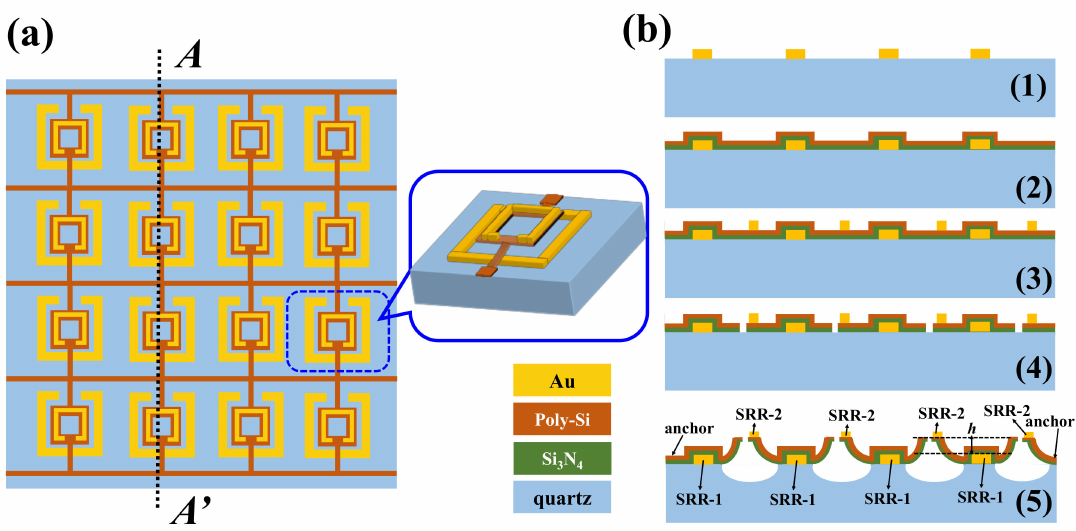
Figure 10. Schematic drawing of ( a ) proposed MEMS-based TTM-1 array; ( b ) Fabrication process of proposed TTM-1 using MEMS technique along AA’ line in ( a ); ( b1 ) The SRR-1 structures are deposited and patterned by using lift-off and sputtering processes sequentially; ( b2 ) The poly-Si and Si 3 N 4 thin-films are deposited on sample surface using PECVD process sequentially. ( b3 ) The SRR-2 structures are deposited and patterned by using lift-off and sputtering processes sequentially. ( b4 ) Sample is patterned by using photolithography and RIE processes to define the ETAs structures. ( b5 ) Sample is released the ETAs structures using VHF to perform the vertical tuning mechanism of